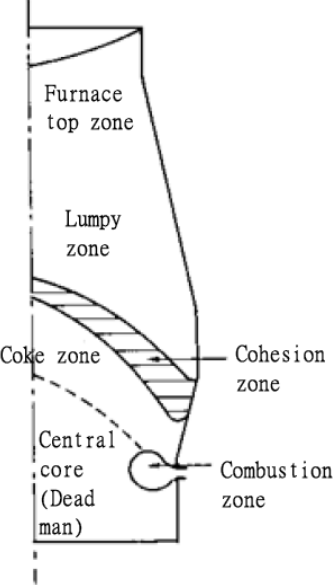
Figure 3. Zones within the blast furnace. Reproduced with permission from [4], Springer, 1987.